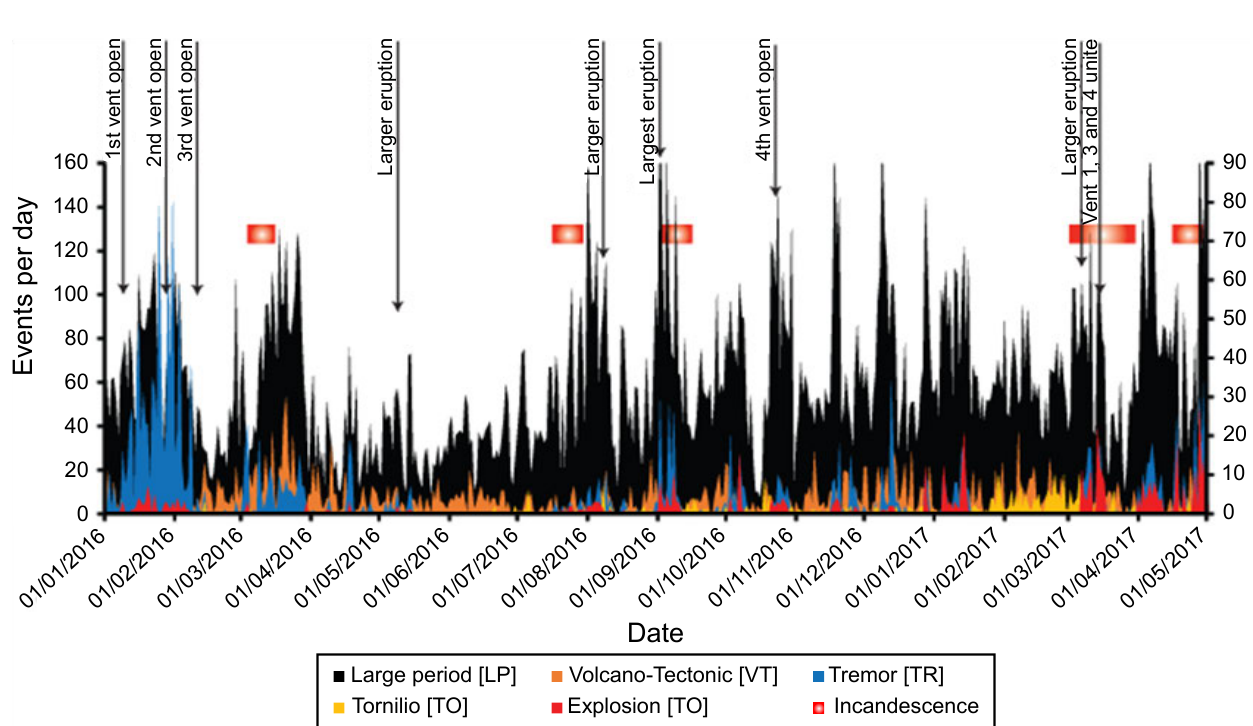
Figure 3: Time series showing the evolution of seismic events for the period of 1 January 2016 to 1 April 2017. Large period events are reported on the left vertical axis while volcano-tectonic, tremor, tornillo and explosions are reported on the right vertical axis. Periods of reported incandescence and specific events are